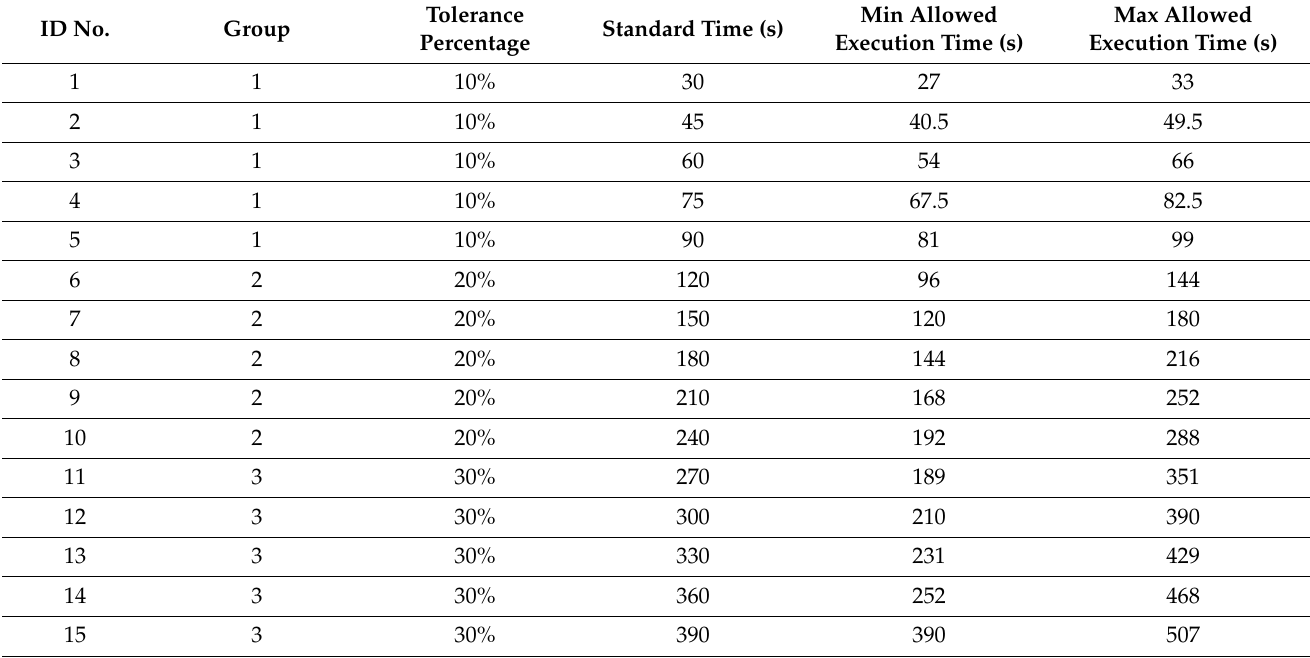
Table 1. Tasks, groups, standard times, and allowed range of execution